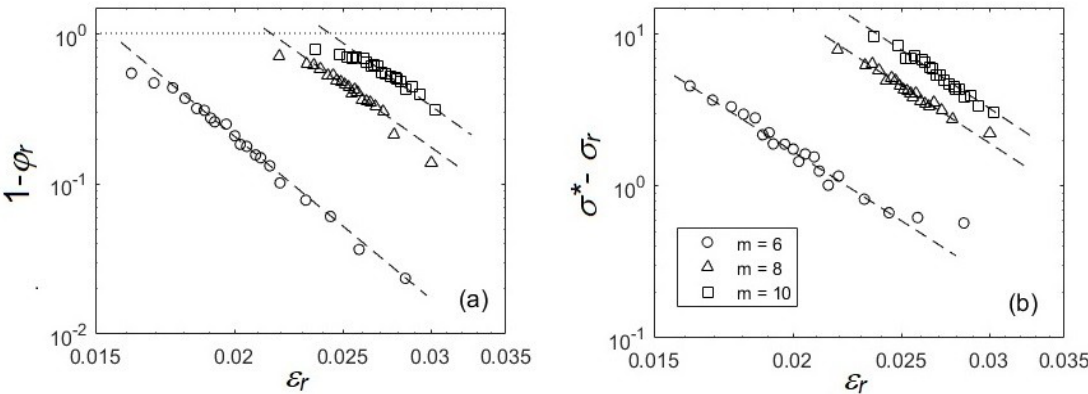
Figure 7. Scaling behavior of the fracture parameters. ( a ) Log-log dependences for the averaged ϕ r ( ε r ) data of Figure 6a and similar datasets corresponding to other choices of (low) m values. The estimates of their slopes render the power-law exponent β about 6 for m = 6 and 5 for m = 8 and m = 10. ( b ) Similar plots for σ r ( ε r )-data. The corresponding slope τ varies around 5.